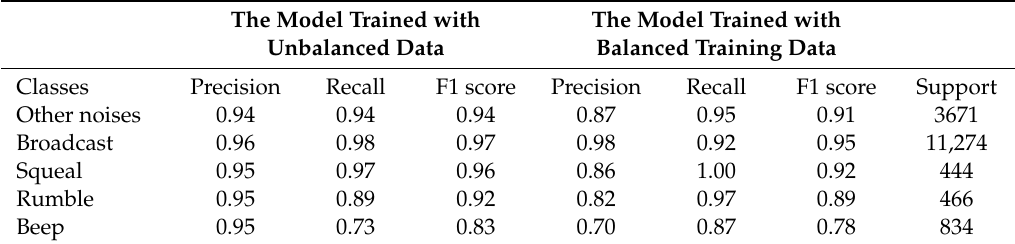
Table 2. Classification reports of test results.